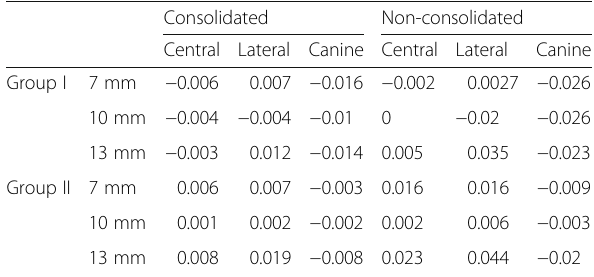
Table 4 Vertical displacements in group I and group II consolidated and non-consolidated models